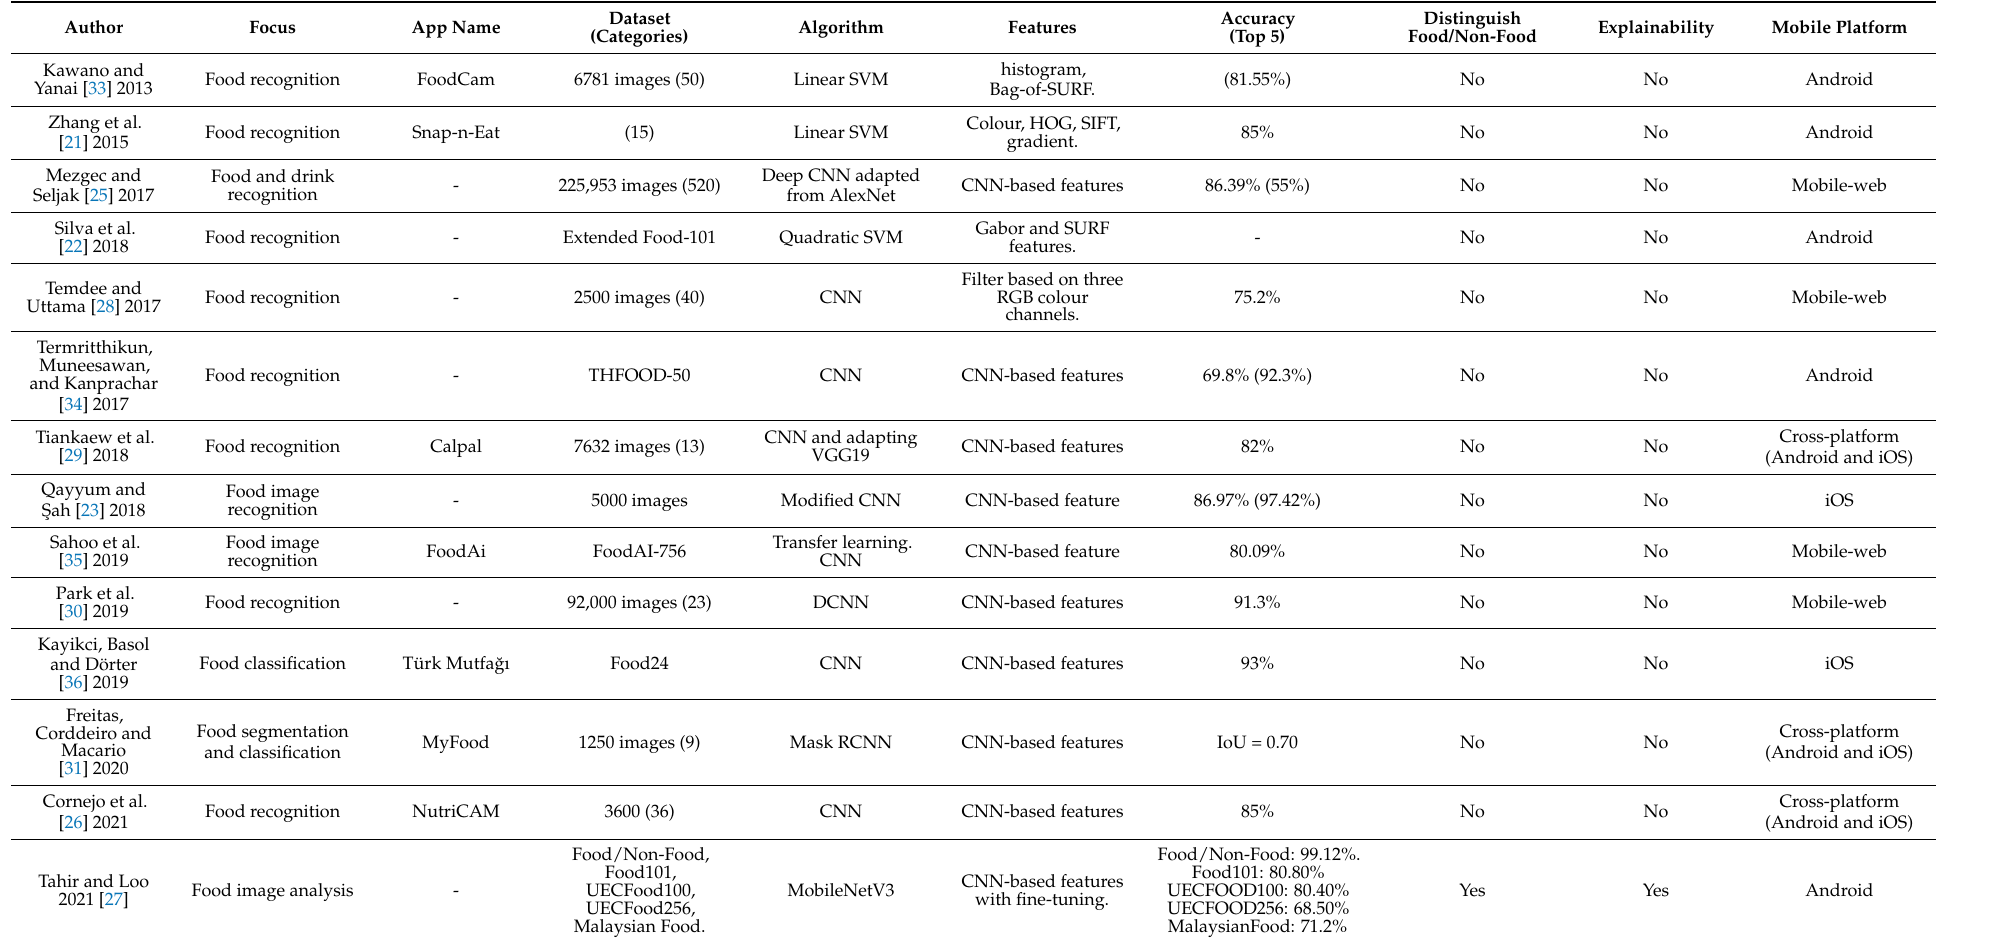
Table 3. Summary of food recognition techniques used by existing computer vision-based mobile